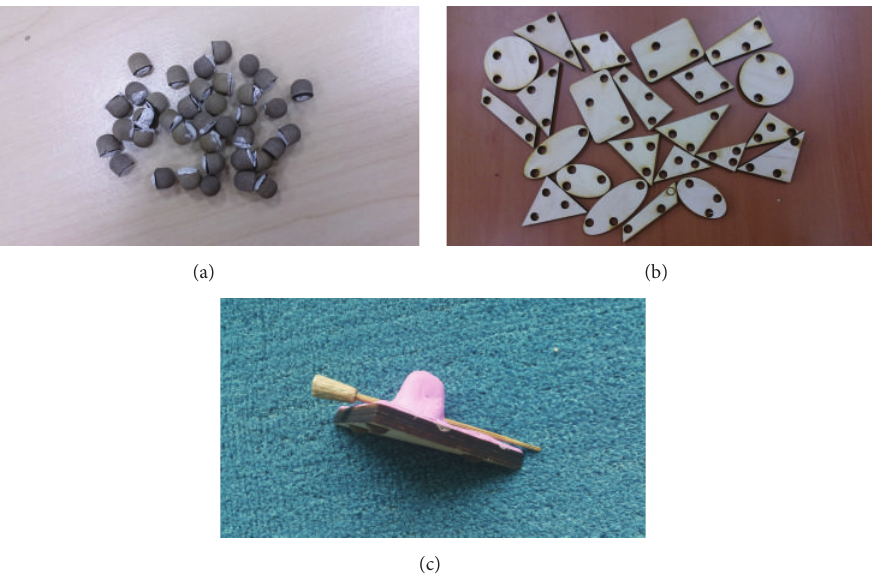
Figure 6: (a) Tips with clay. (b) Tangible baseplate. (c) A completed